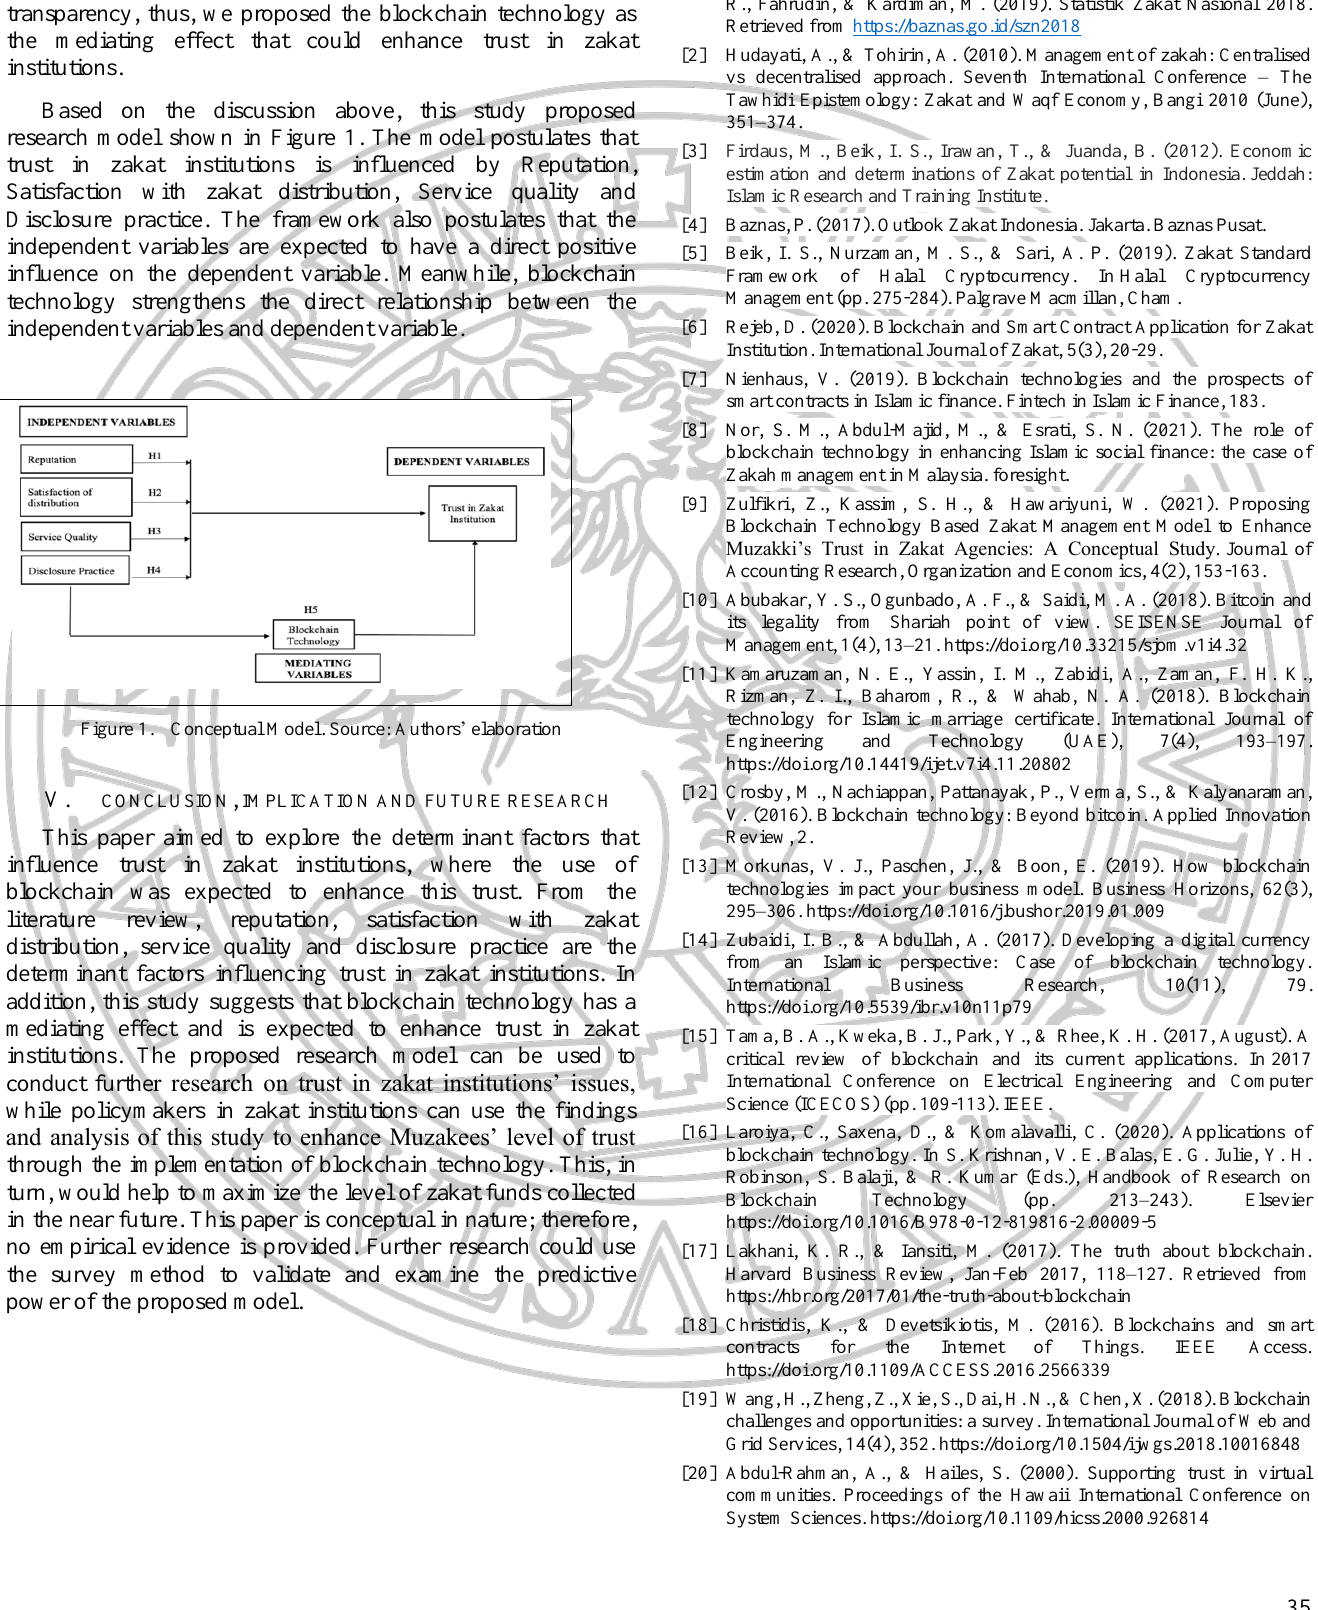
Figure 1. Conceptual Model. Source: Authors’